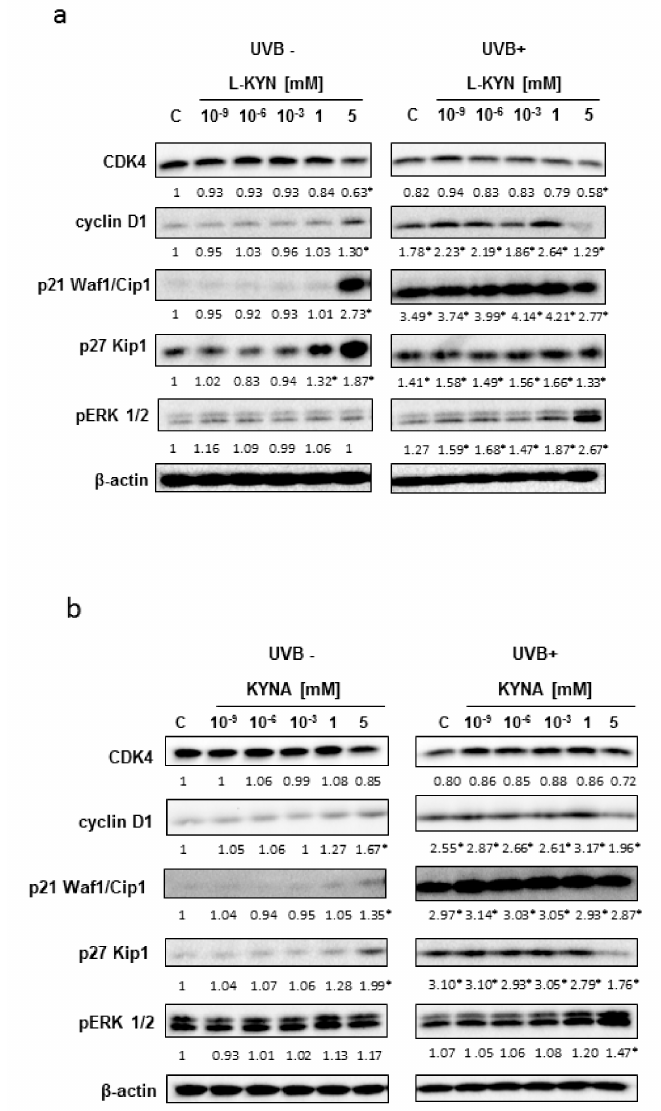
Figure 5. The effect of UVB on selected cell cycle regulators and activation of the ERK signaling pathway in melanoma SK-MEL-3 exposed to KYN ( a ) and KYNA ( b ). Melanoma SK-MEL-3 cells were exposed to UVB (UVB+) and then to culture medium (control, C) or serial dilutions of KYN and KYNA (10 − 9 , 10 − 6 , 10 − 3 , 1, and 5 mM) for 24 h. Similarly, the biological activity of KYN and KYNA was studied in melanoma cells under standard conditions (UVB − ). The effect of UVB and tested substances on the protein level of selected cell cycle regulators (cyclin D1, CDK4, p21 Waf1/Cip1, and p27 Kip1) and activation of ERK1/2 kinase was determined by means of Western blot. Western blots were selected as the most representative of the series of repetitions. UVB − and UVB+ bands represent the same blot. The results of densitometric analysis, normalized relative to β -actin, are shown as relative value of the control (“*”, the fold changes in protein expression ≥ 30% were considered significant; qualitative